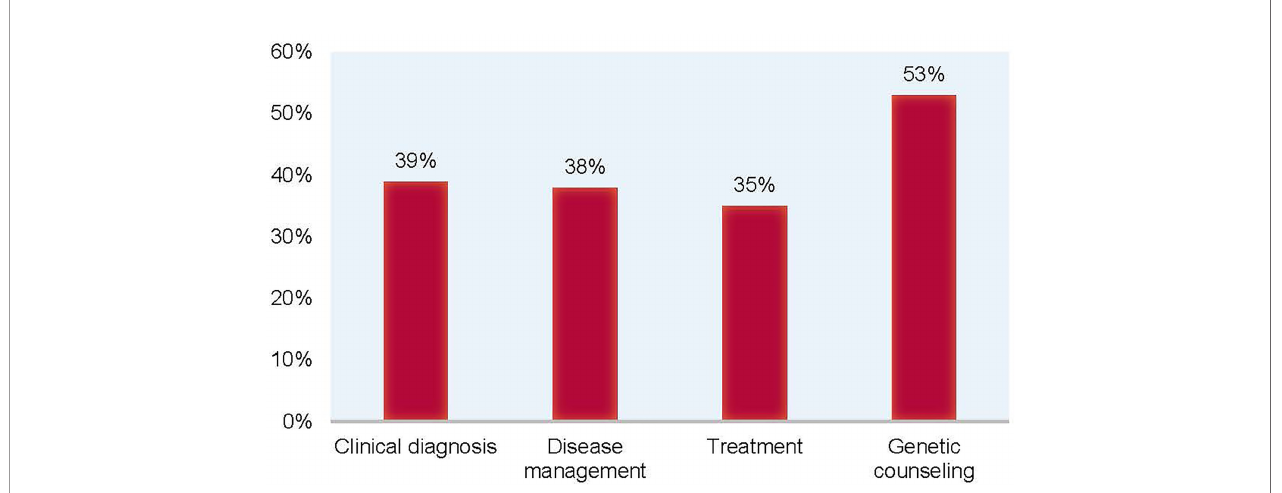
FIGURE 4 | Alteration rates of clinical diagnosis, disease management, treatment, and genetic counseling in patients after NGS testing. Through the questionnaire, participating clinicians reported that based on the results of NGS testing, clinical diagnosis was altered in 39% of patients, disease management was altered in 38% of patients, treatment was altered in 35% of patients, and genetic counseling was altered in 53% of patients.